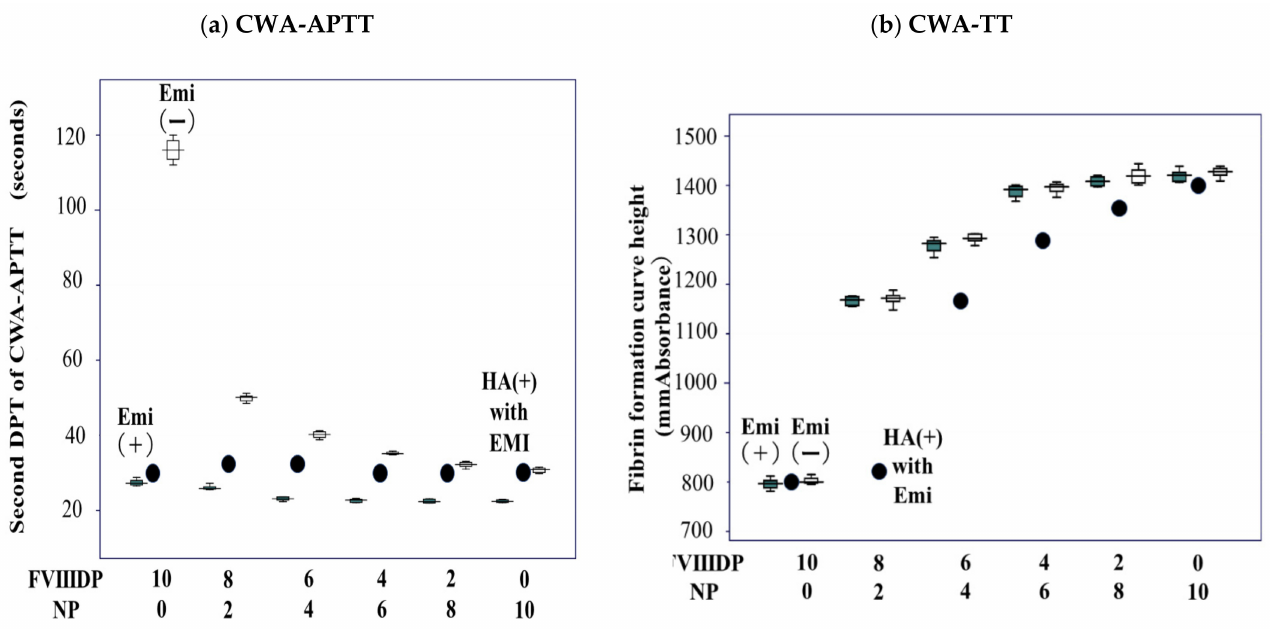
Figure 3. Clotting activation by thrombin using clot waveform analysis of thrombin time. NP, normal plasma; FVIIIDP, FVIII-deficient plasma; Emi, emicizumab. navy-blue, fibrin formation curve; pink curve, 1st derivative curve; light-blue curve, 2nd derivative curve. All assays were performed more than three times to confirm the reproducibility.